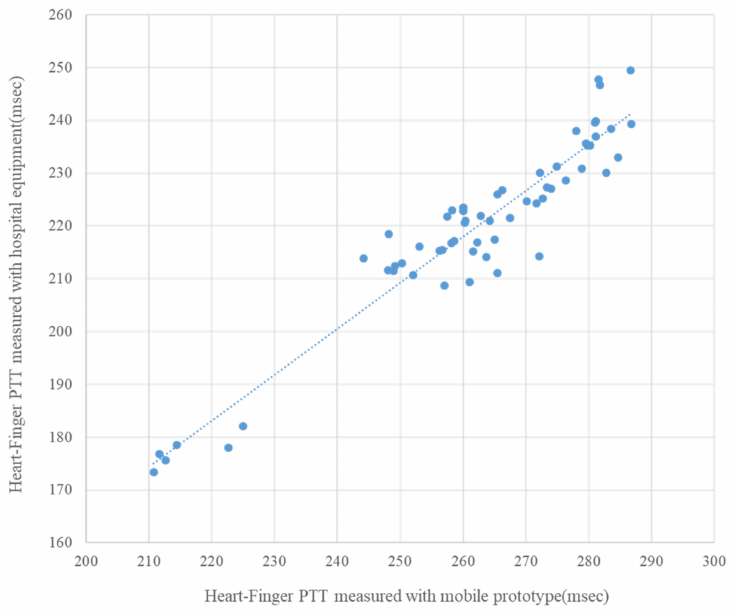
Figure 10. Comparison of pulse transit time data measured with commercial hospital equipment and a mobile prototype in 10 subjects (r = 0.95, p <